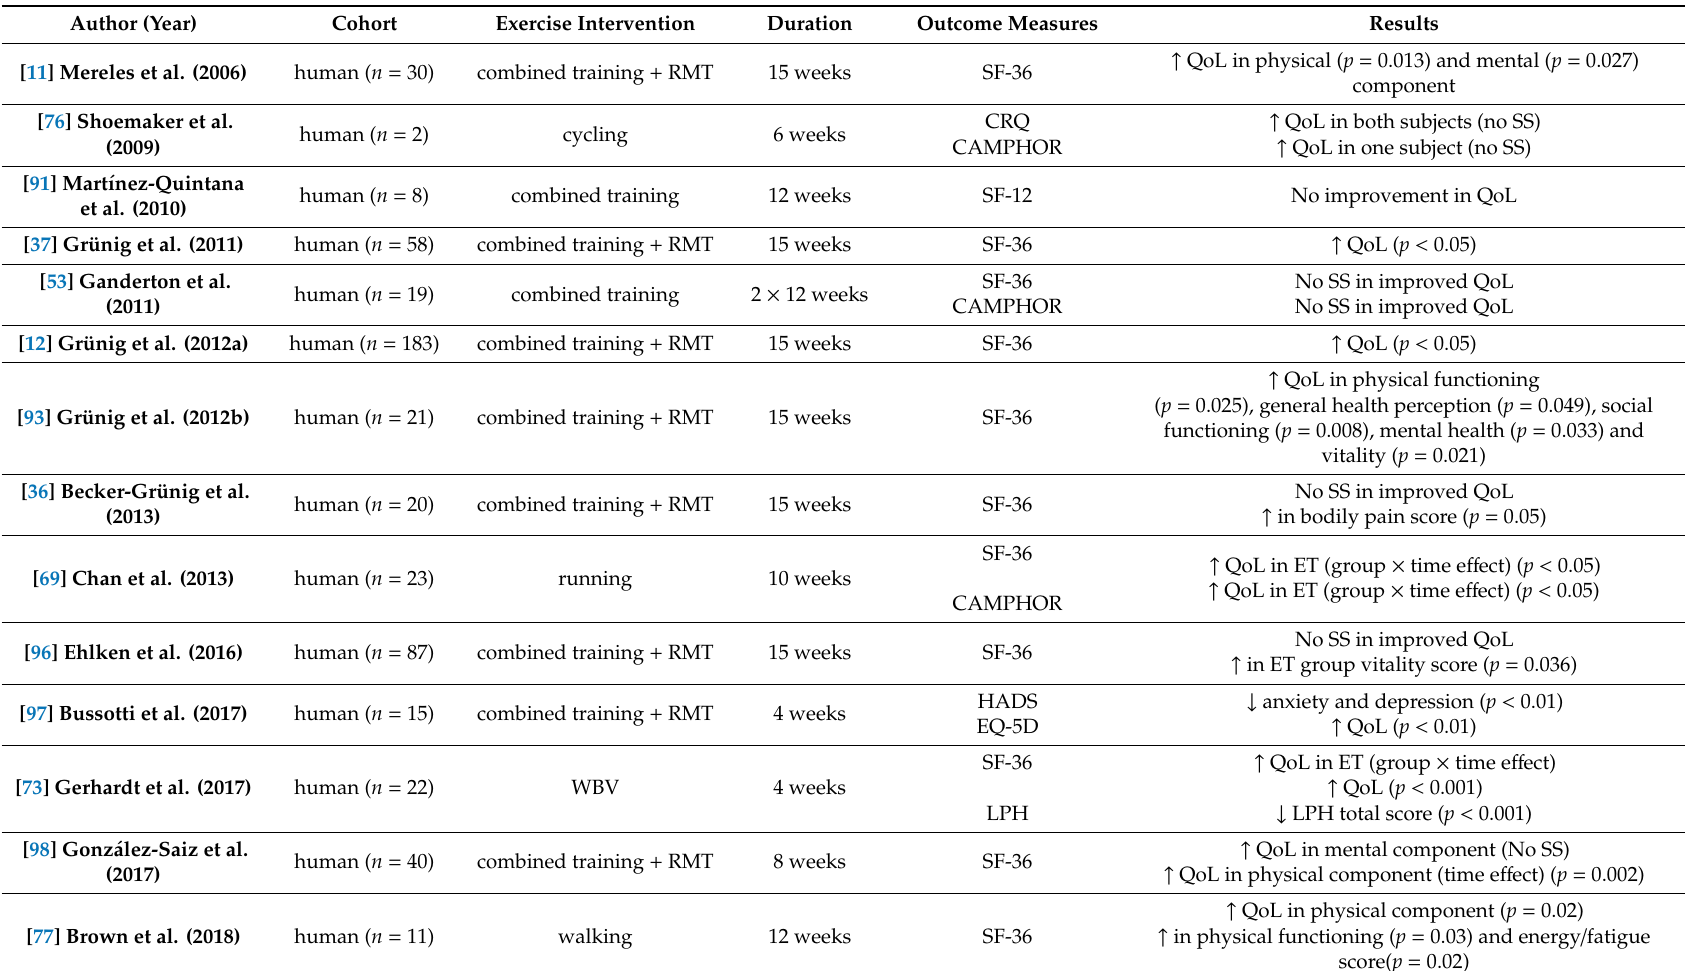
Table 8. Summary of studies examining psychological factor–QoL ( n =